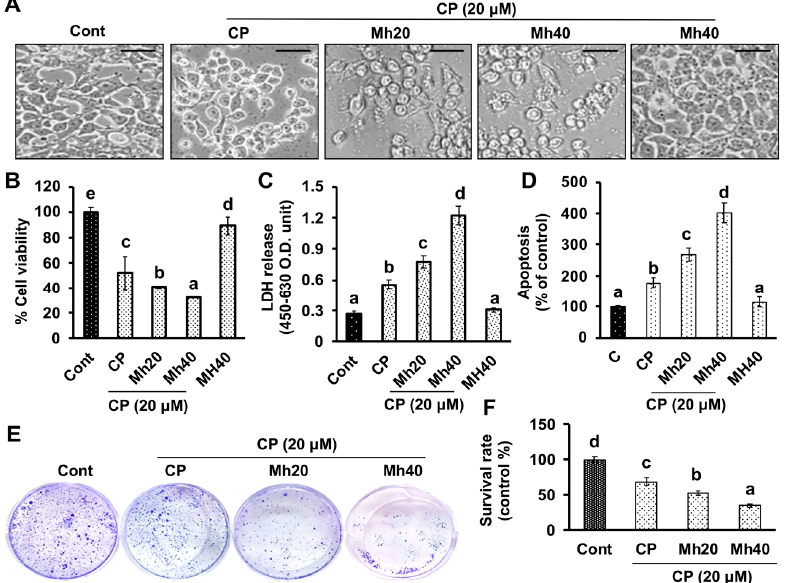
Figure 1. E ff ect of cisplatin (CP), Mh and CP-Mh on HepG2 cell viability. ( A ) The microscopic images of HepG2 cells morphology after corresponding drug treatment (scale bar 0.1 mm). ( B ) HepG2 cells viability measurement by 3-(4,5-dimethylthiazol-2-yl)-2,5-diphenyltetrazolium bromide (MTT)